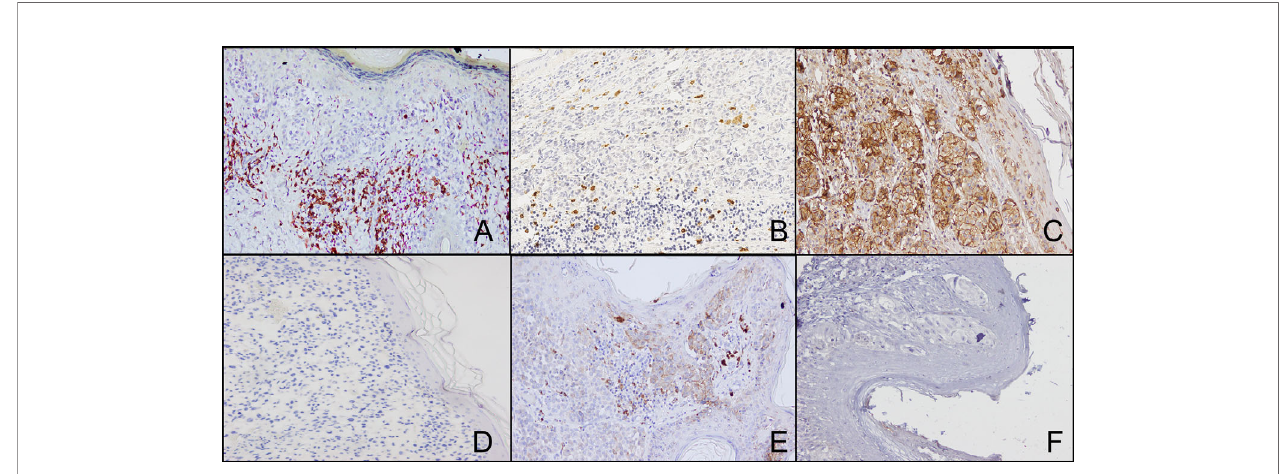
FIGURE 3 | Representative staining patterns of formalin- fi xed, paraf fi n-embedded thin melanoma lesions with CD8- (A) , FOXP3- (A) , GRZ-B- (B) , HLA class I antigen- (C) and PD-L1- (E) speci fi c mAbs. Double IHC staining was performed utilizing CD8- (brown cells) and FOXP3- (red cells) speci fi c mAbs (A) . For HLA class I antigen detection tissue sections were IHC stained with a pool of mouse HLA-A – speci fi c mAb HCA2 and HLA-B/C-speci fi c mAb HC10 (ratio, 1:1). mAbs E7Q5L (IgG2b) and DA1E (IgG) were used as isotype controls for HLA class I antigen (D) and PD-L1 (F) staining, respectively. Magni fi cation is